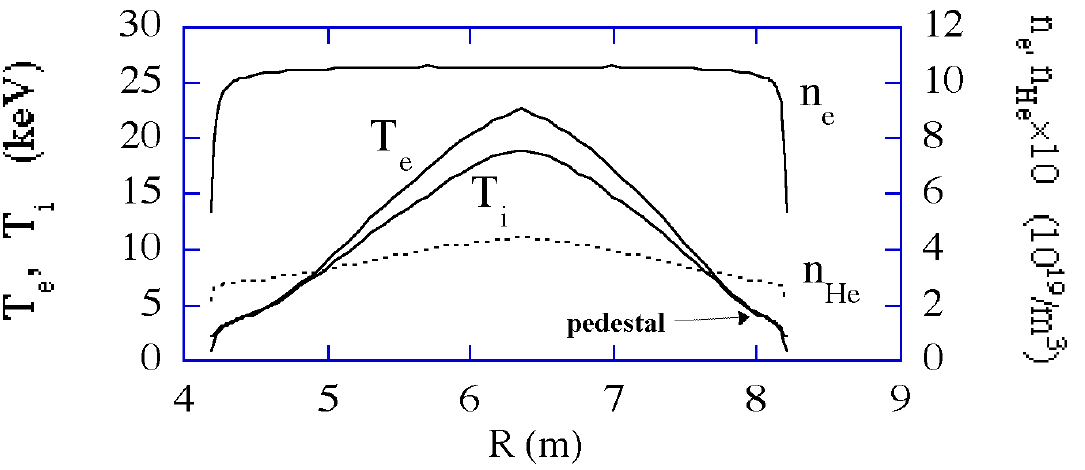
Figure 6. Profiles of electron temperature ( T e ), ion temperature ( T i ), electron density ( n e ), and helium density ( n He ) through the toroidal cavity (from ITER Technical Basis [4]). © 2002 IAEA.